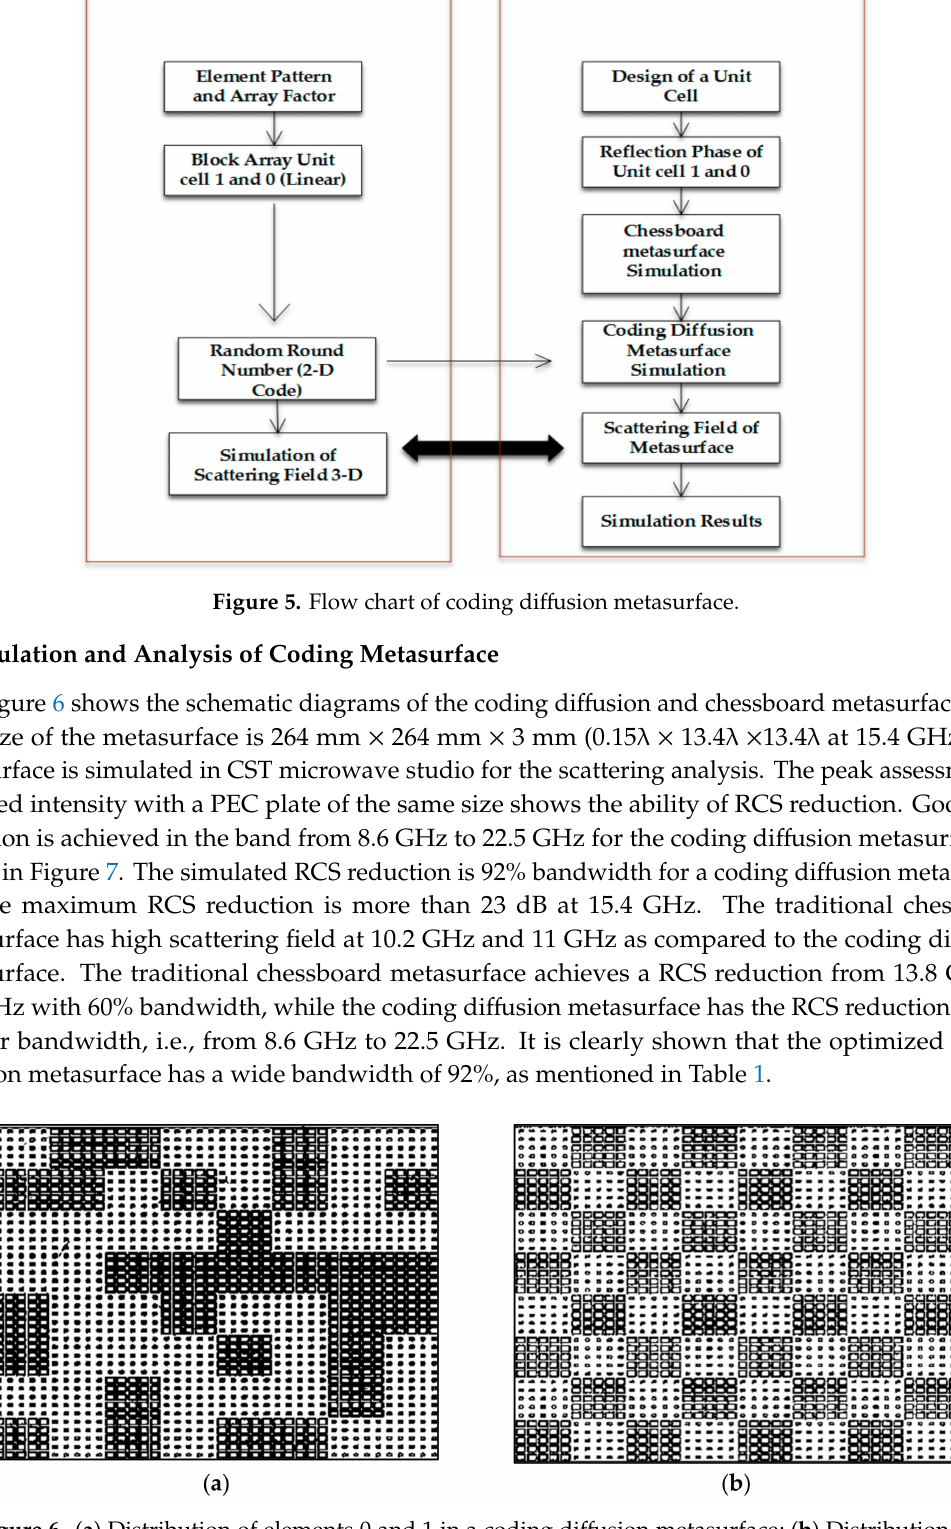
Figure 6. ( a ) Distribution of elements 0 and 1 in a coding di ff usion metasurface; ( b ) Distribution of elements 0 and 1 in a chessboard